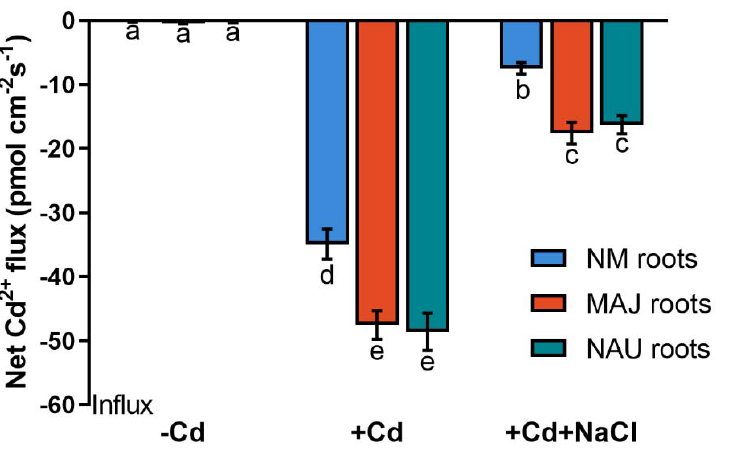
Figure 2. Steady-state Cd 2+ fluxes in non-mycorrhizal (NM) Populus × canescens and ectomycorrhizal (EM) roots under cadmium and salt stress. Poplar plantlets inoculated with or without Paxillus involutus isolates (MAJ or NAU, 30 d), were hydroponically acclimated and subjected to 24 h of CdCl 2 (0 or 50 µ M) in combination with NaCl (0 or 100 mM). Root tips were excised from EM- and NM-poplars and equilibrated for 30 min in measuring solution. Net fluxes of Cd 2+ along root axis (100 to 2300 µ m) were monitored at an interval of 200–300 µ m (Figure S1). Mean values of Cd 2+ fluxes in control ( − Cd), CdCl 2 stress (+Cd), and combined stress of CdCl 2 and NaCl (+Cd + NaCl) are shown. Cd 2+ flux was not detectable in salt controls that were treated without CdCl 2 . Each column is mean ± SD obtained from 5 individual plants. Statistically significant differences ( p < 0.05) among treatments are indicated with different letters (a–e).